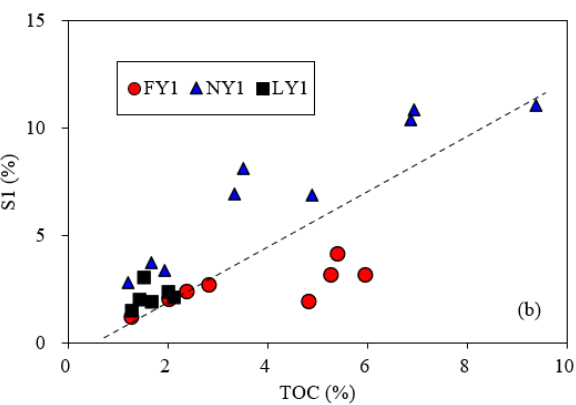
Figure 9. Plots showing relationships of TOC with EOM ( a ) and S1 ( b ) for the studied samples.